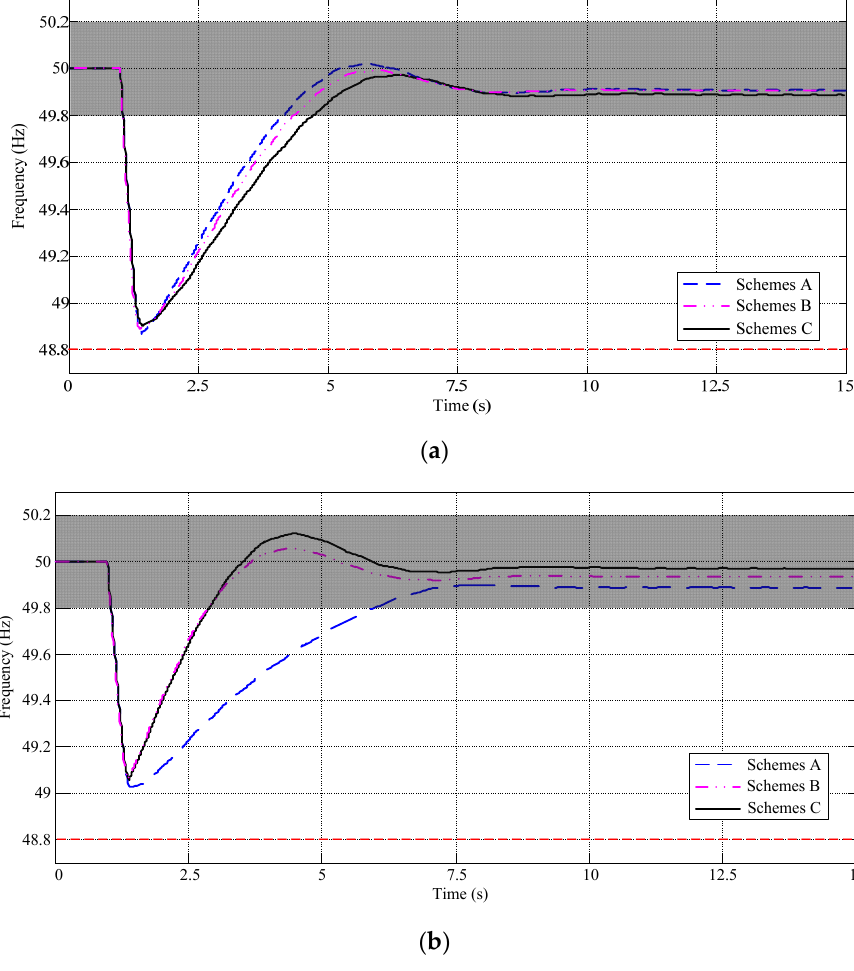
Figure 12. System frequency responses with optimized UFLS schemes under different conditions: ( a ) Peak demand; ( b ) Valley demand.